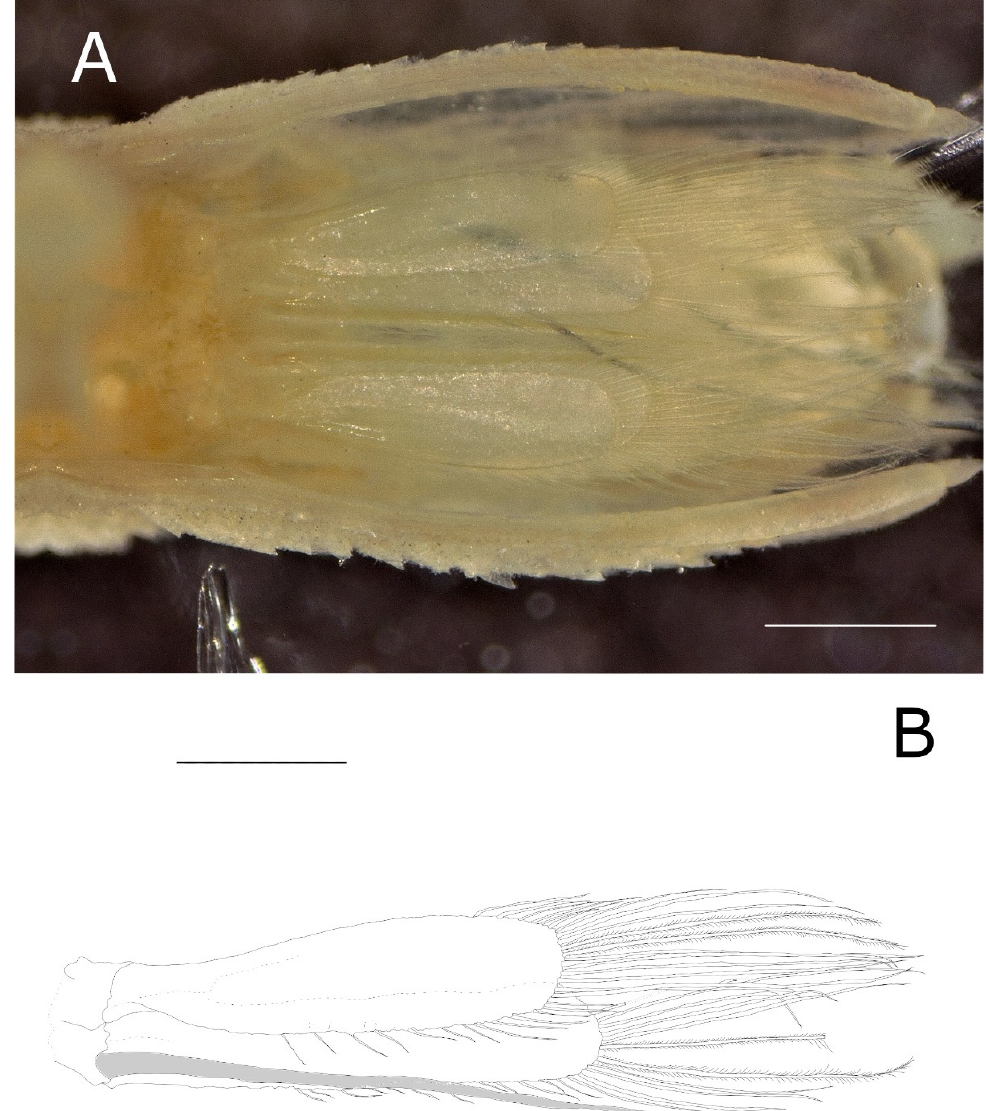
Figure 7. Chaetarcturus cervicornis sp. n., male holotype (MNA 10739) PL2 table ( A ) stack photo of respiratory chamber, focusing on second pleopods ( B ) second pleopod and appendix masculina (in grey) digital inking drawing. All scale bar = 1 mm.